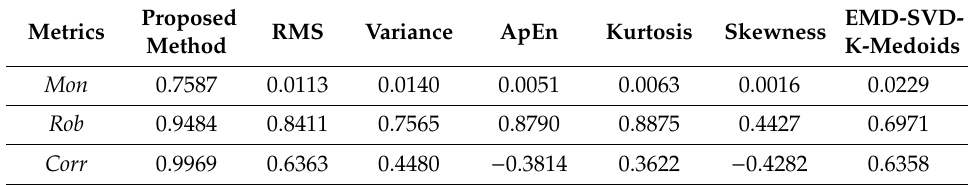
Table 2. Comparison of health indicators based on monotonicity (Mon ), correlation ( Corr ), and robustness ( Rob ) for subset 2 bearing